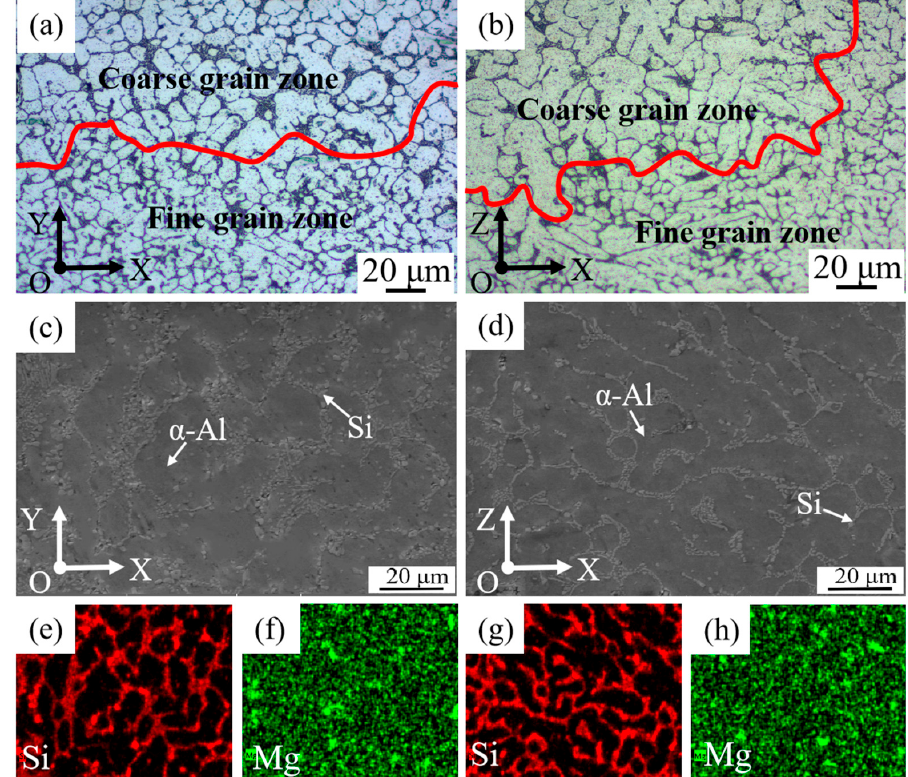
Figure 4. Metallographic morphology, scanning electron microscope (SEM) and energy disperse spectroscopy (EDS) graphs of the as-deposited samples: ( a ) face XOY; ( b ) face XOZ; ( c ) face XOY; ( d ) face XOZ; ( e , f ) Distribution of Si, Mg elements of ( c ) respectively; ( g , h ) Distribution of Si, Mg elements of ( d ) respectively.